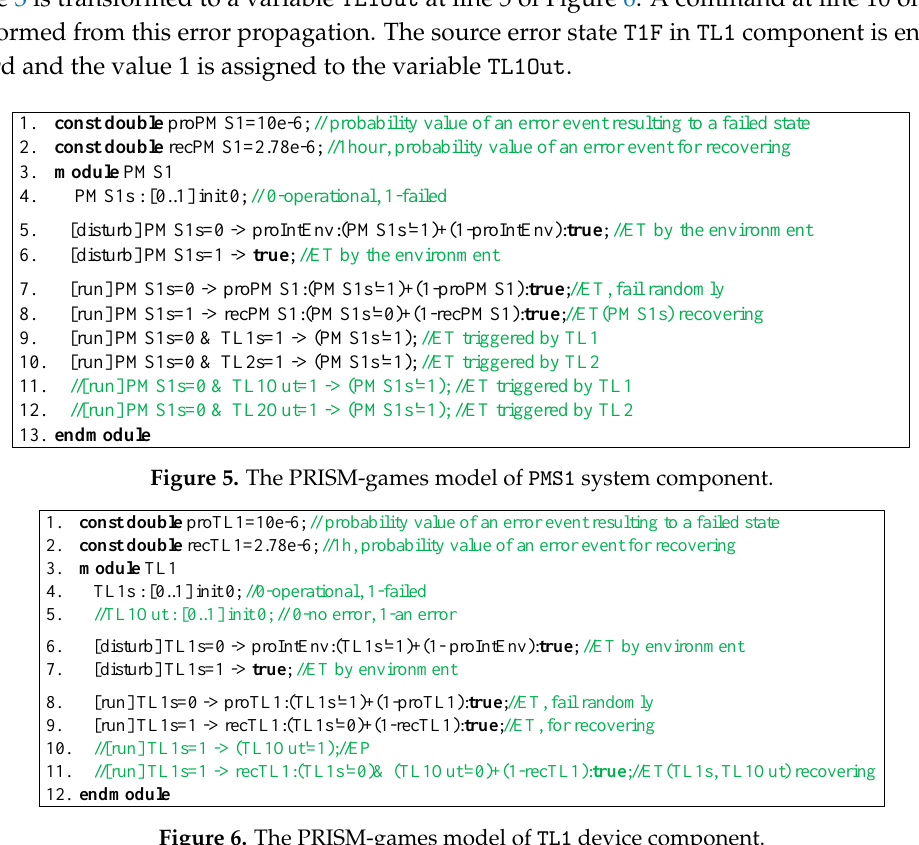
Figure 6. The PRISM-games model of TL1 device